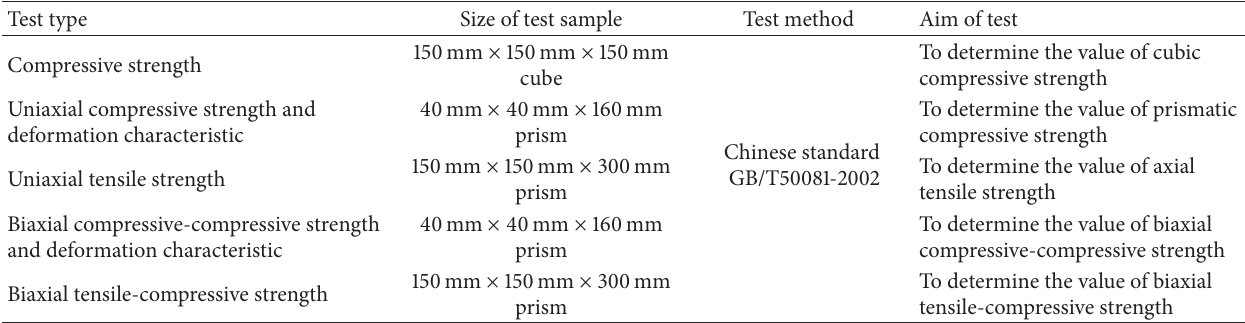
Table 2: Description of different experimental studies.